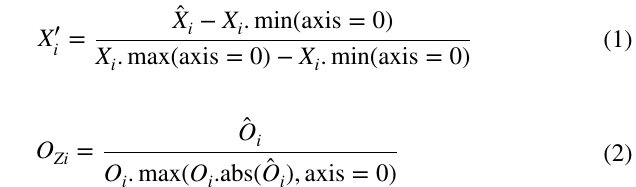
Table 2 The data selection deviations of the actual loading